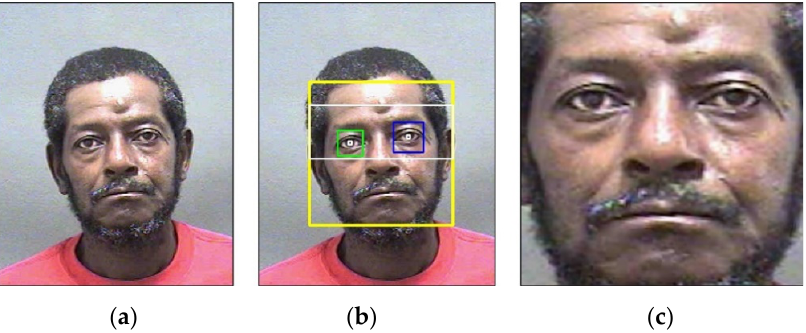
Figure 2. Procedure of pre-processing of the face region. ( a ) Original PAL database image. ( b ) Detected face and eye regions using the Adaboost algorithm. ( c ) In-plane rotation compensation and face ROI redefinition.